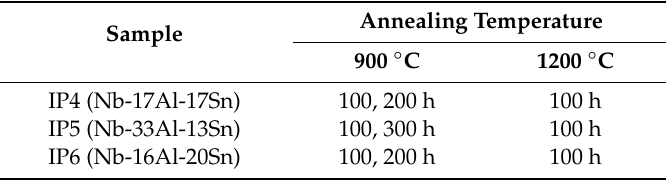
Table 1. Annealing times for samples at 900 and 1200 ◦